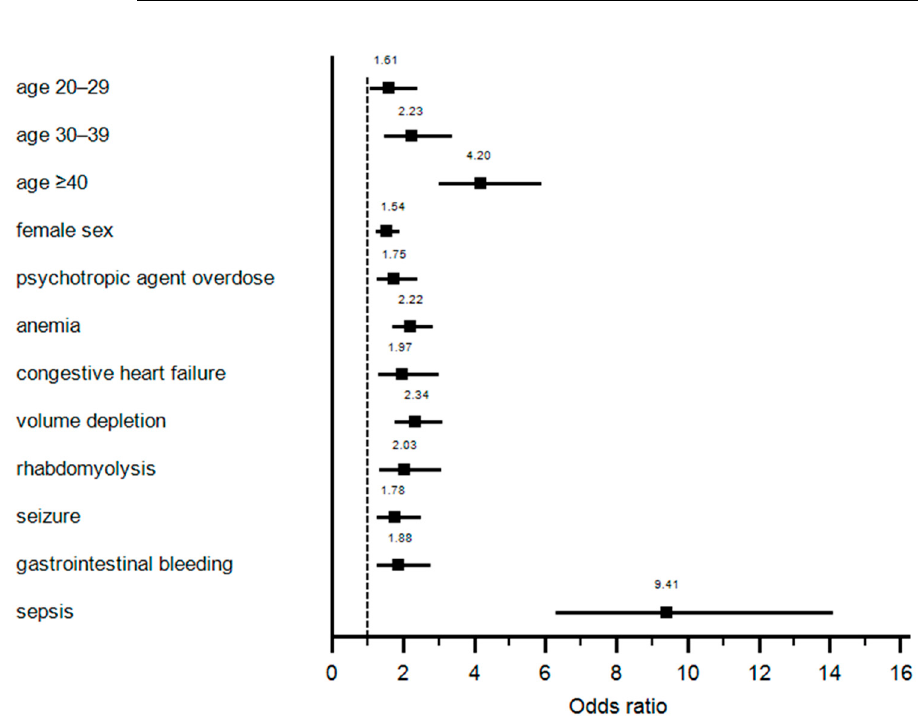
Figure 1. Independent risks factors for development of circulatory shock.